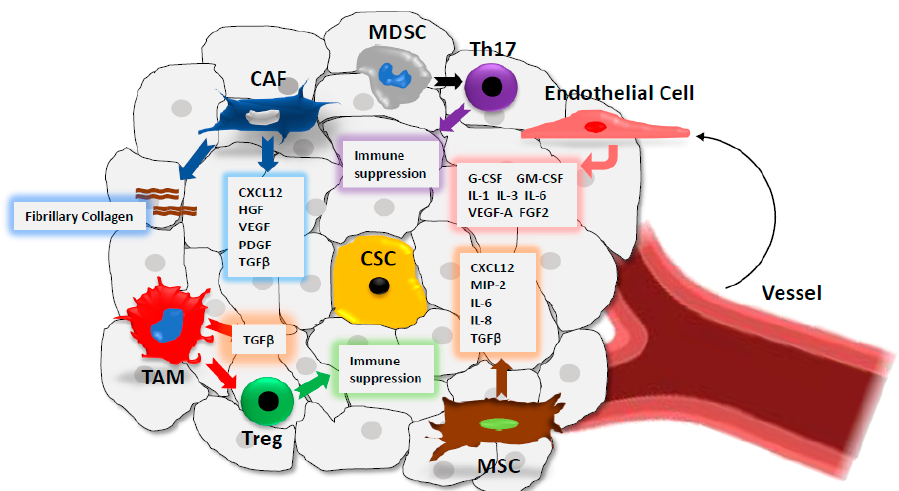
Figure 2. Schematic representation of the CSC microenvironment (CSC niche). The complex CSC niche contains several cell types including mesenchymal stem cells (MSCs), endothelial cells, cancer associated fibroblasts (CAFs) and immune cells (tumour associated macrophages (TAMs), regulatory T cells (Tregs), myeloid-derived suppressor cells (MDSCs) and T-helper cells (Th17)). These cells secrete different cytokines and growth factors that promote tumourigenesis, tumour progression and immunosuppression.